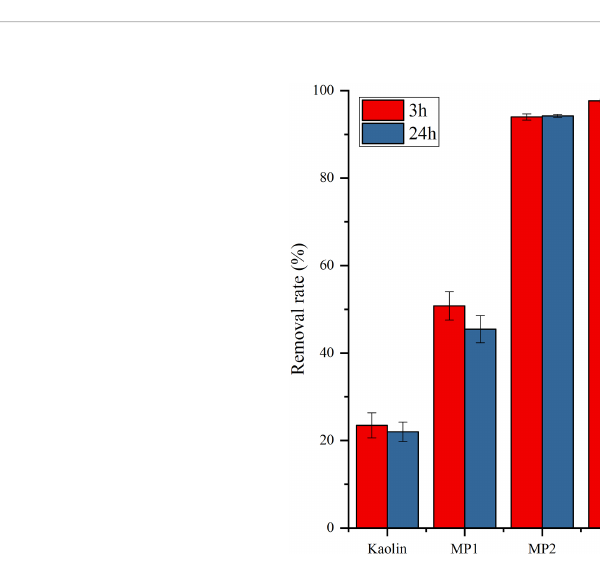
FIGURE 1 Removal effects of two modi fi ed clays on P. Donghaiense